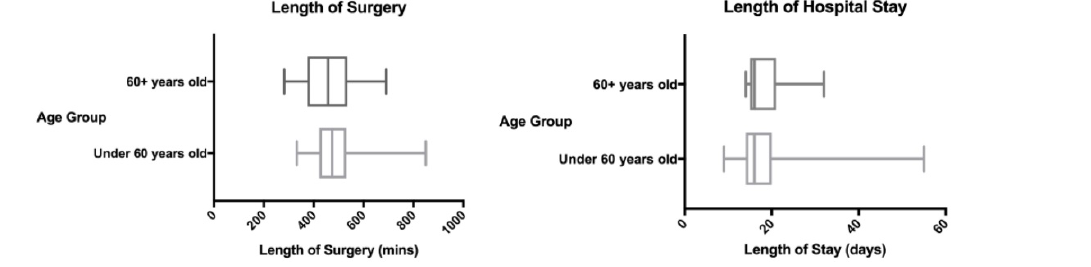
Figure 2 : Length of procedure and length of